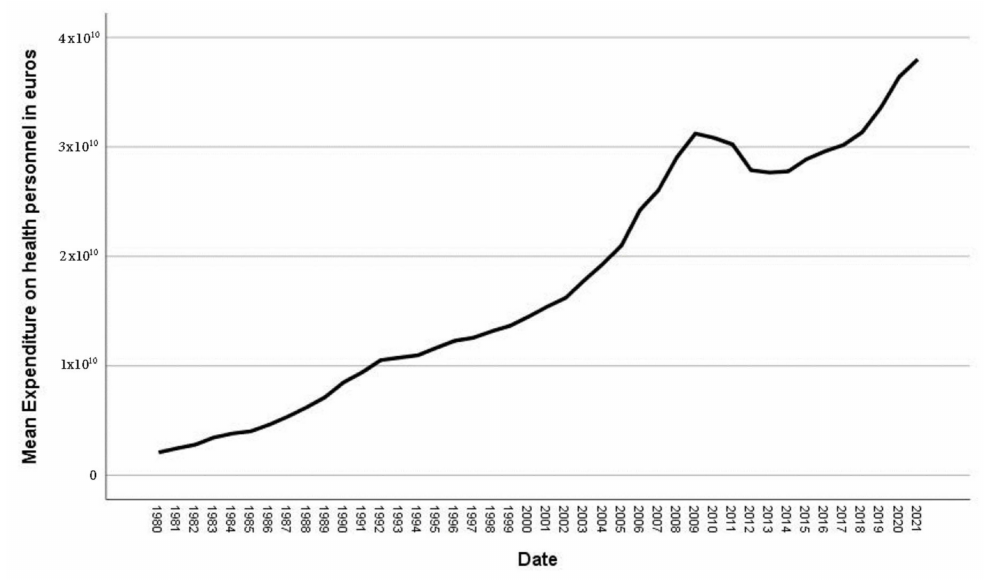
Figure 4. Evolution expenditure on health personnel. Source: National Statistics Institute (INE)